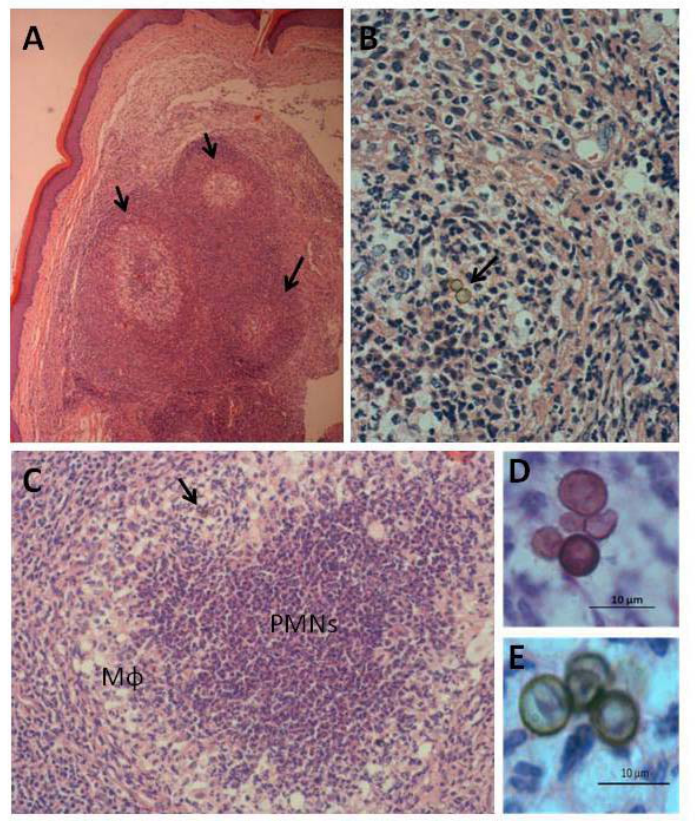
Figure 6. Photomicrography of histopathological sections from footpad tissue of animals with chronic experimental CBM infection at seven months after infection; tissue was stained with PAS. ( A , arrows) Granulomatous reaction containing microabscesses with neutrophilic infiltration, foamy macrophages, low numbers of lymphocytes and eosinophils, and ( B ) recovery by fibroblasts. Few sclerotic cells of F. pedrosoi were found in granulomas of mice inoculated at ( C ) one site or ( B ) two sites. ( C ) PMN rich cellular infiltration surround by macrophages (M φ ) of animal tissue infected at one site. ( D and E ) Sclerotic cells with diameters ranging from 5 to 10 µm.